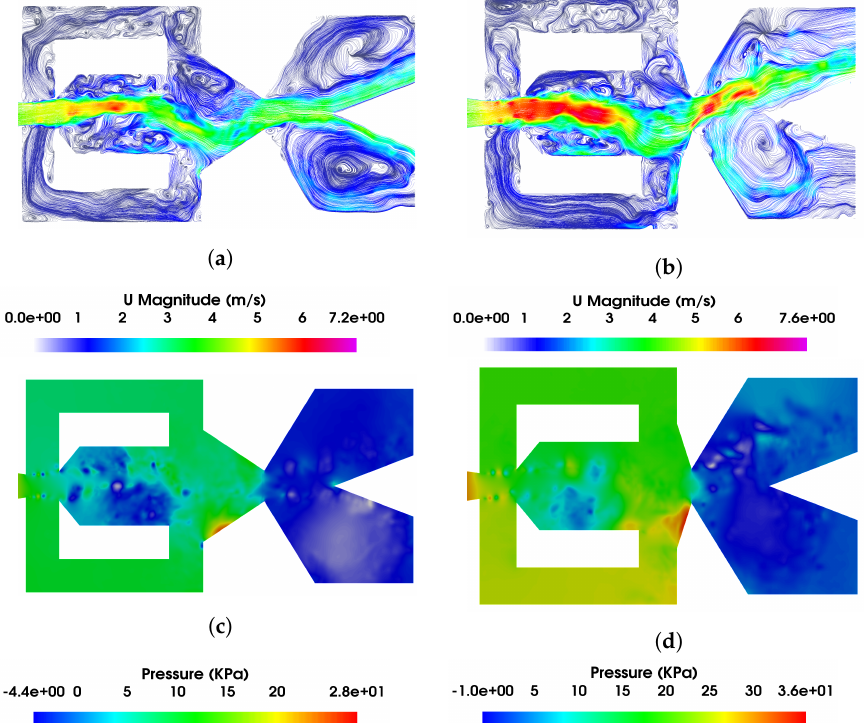
Figure 11. Fluidic oscillator internal velocity field ( a , b ) and pressure magnitude ( c , d ). Maximum outlet angle ( a , c ), minimum outlet angle ( b , d ). Reynolds number